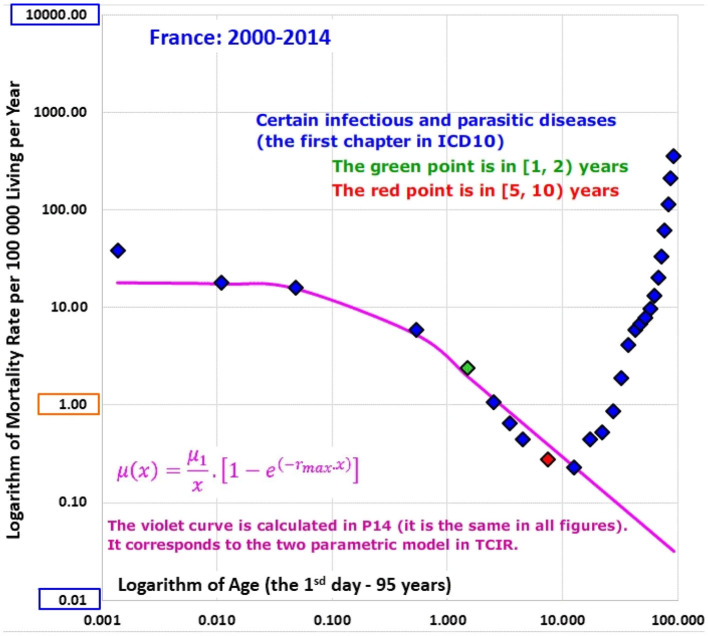
(Animation 3) Certain infectious and parasitic diseases in France.